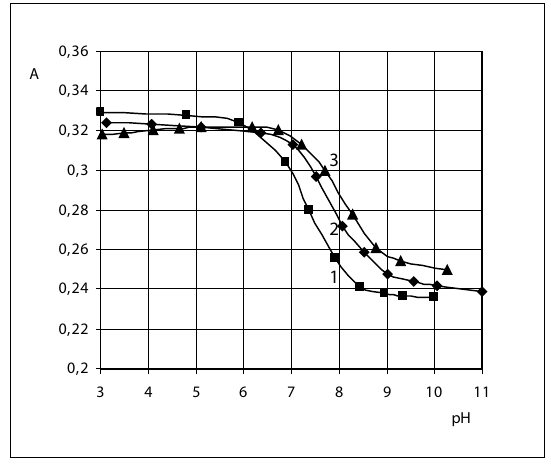
Figure 3. Absorbance-pH curves of sanguinarine at different HCl concentrations. Experimental conditions: 1 – 0.001 mol L -1